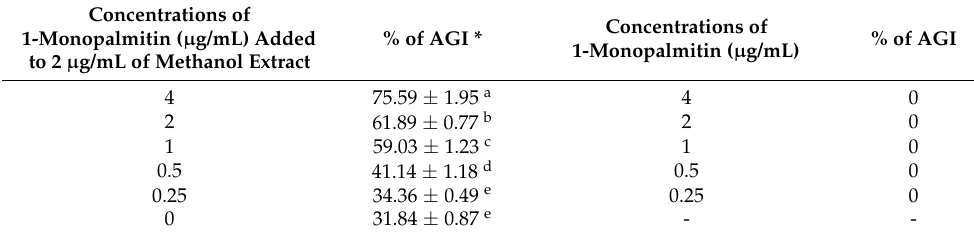
Table 4. Synergistic activity of 1-monopalmitin.